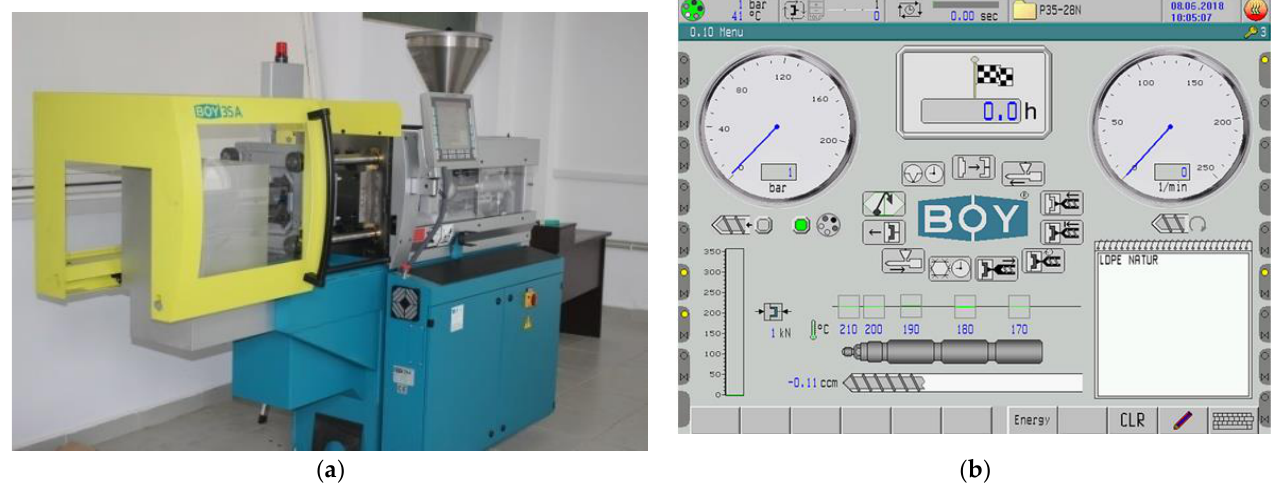
Figure 9. The injection machine ( a ); the control monitor of the injection machine ( b ). Table 1. Temperature regime of the injection